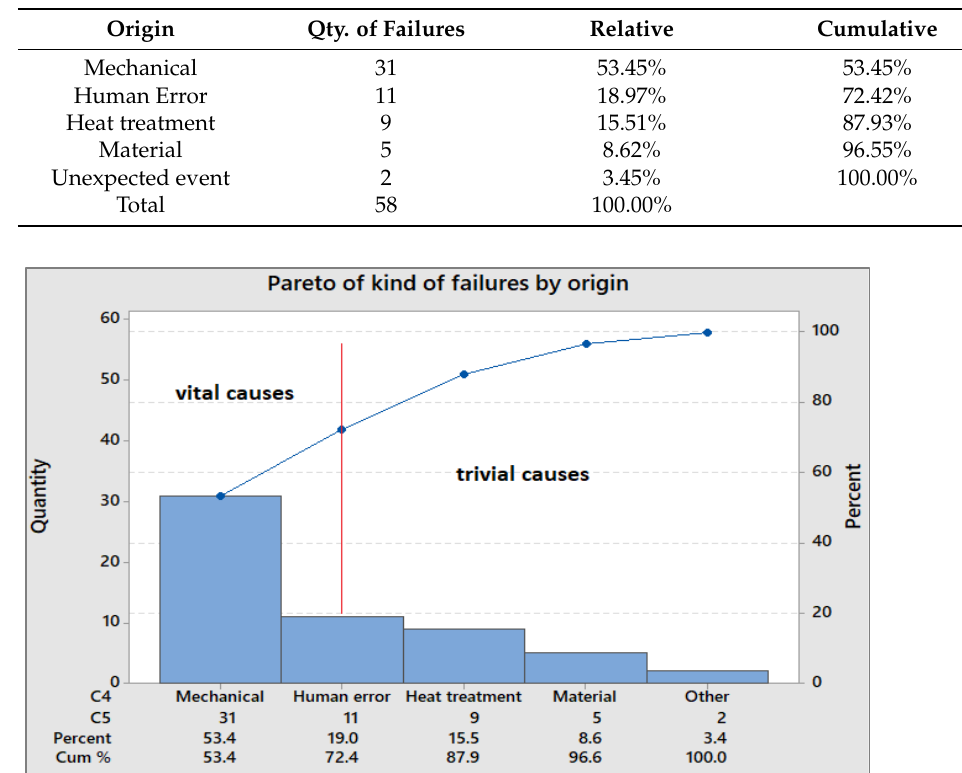
Figure 5. Pareto diagram of the origins of failures and their contribution.